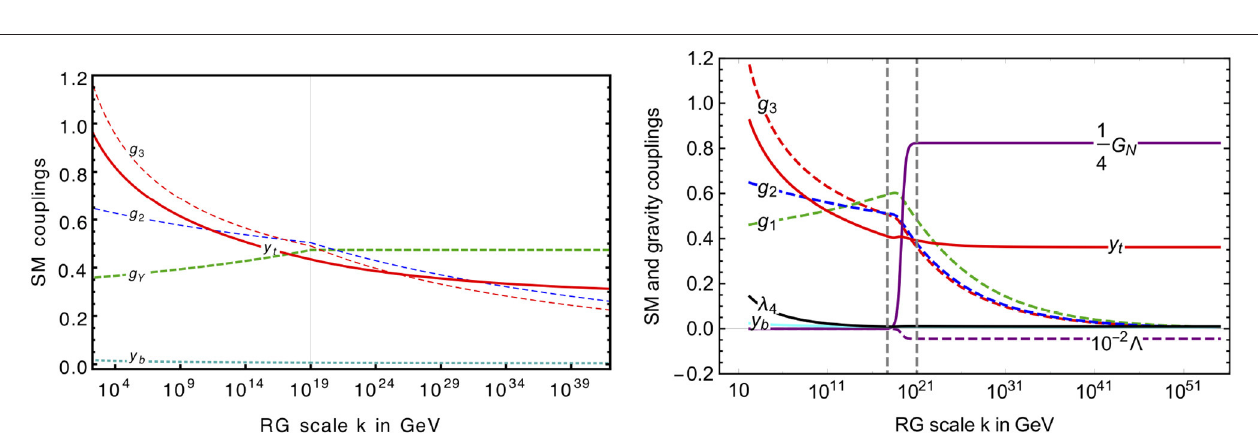
FIGURE 13 | Both panels: RG flows in an approximation as in Equation (56), see Eichhorn and Held (2018) and Eichhorn and Held (2018) for details. Left panel: Flow of gauge couplings and top and bottom Yukawa with quantum-gravity parameterized by f g below the Planck scale as in Eichhorn and Held (2018). Right panel: Standard-Model RG flow including running gravitational couplings as in Donà et al. (2014) and is taken from Eichhorn and Held